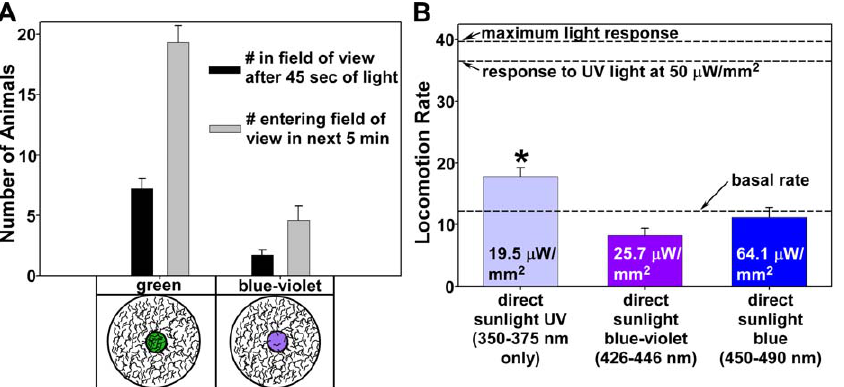
Figure 5. The C. elegans Light Response may be a Photophobic Response to the UV Light in Direct Sunlight (A) Worms actively avoid blue-violet light. Field-of-view clearing assays on crowded plates of N2 (wild type) in green versus blue-violet light. Each plate contained 4,500 young adult animals at a density of 1.6 animals/mm 2 . Error bars are the standard errors from ten trials. (B) The UV light in direct sunlight is sufficient to cause a locomotory response. Shown are the mean locomotion rates of wild type in ultraviolet, blue- violet, and blue light of powers found in direct sunlight. Note that the UV power measured by the light detector at the culture plate surface is restricted to wavelengths in the 350–375-nm range due to adsorption of lower wavelengths by glass in the microscope objective. Therefore, the power reading of 19.5 l W/mm 2 , taken at the culture plate surface, was biased toward longer wavelengths of the DAPI filter (350–375 nm). Sunlight passing through the DAPI filter directly onto the detector contains all wavelengths from 325–375 nm (because it does not go through glass), so the sunlight power reading of 19.5 l W/mm 2 reflects both short and long wavelengths of UV. It is likely that the shorter wavelengths of UV light in sunlight, including wavelengths shorter that those passed by the DAPI filter, are required to maximize the locomotion response. Indeed, sunlight UV wavelengths down to 291 nm reach Earth’s surface [7], and this is well below the range of the DAPI filter. The asterisk indicates statistical significance, with a p- value of 0.015 using the unpaired t -test with the Welch correction. Error bars are the standard errors in populations of ten animals.